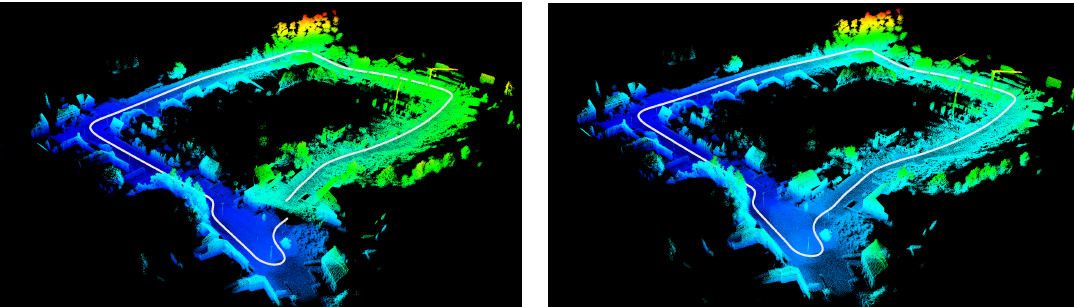
Figure 8. The two resulting reconstructions for the “Hasselt” dataset, before loop closure ( left ) and after loop closure ( right ). After loop correction, the two ends of the loops were attached, and the error was propagated back in the pose